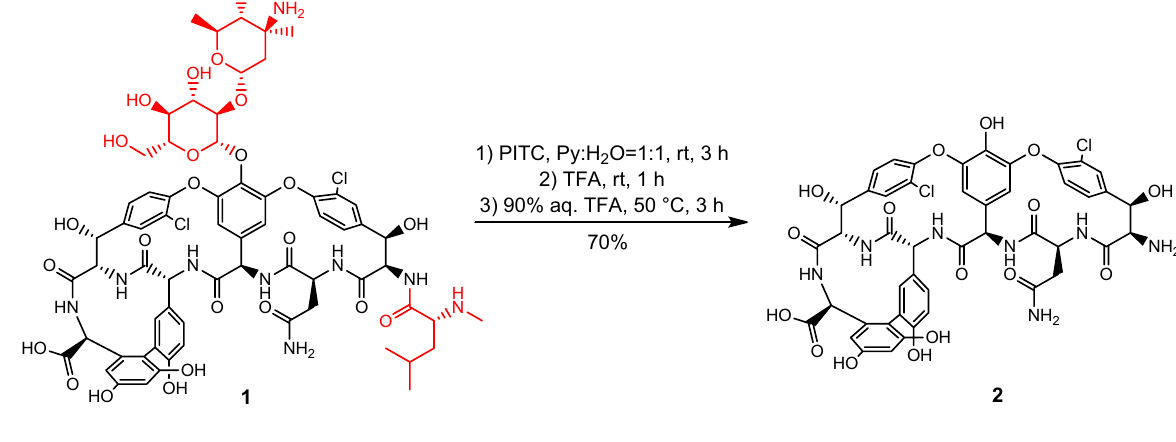
Figure 2. Synthesis of vancomycin aglycone hexapeptide (VAHP) 2